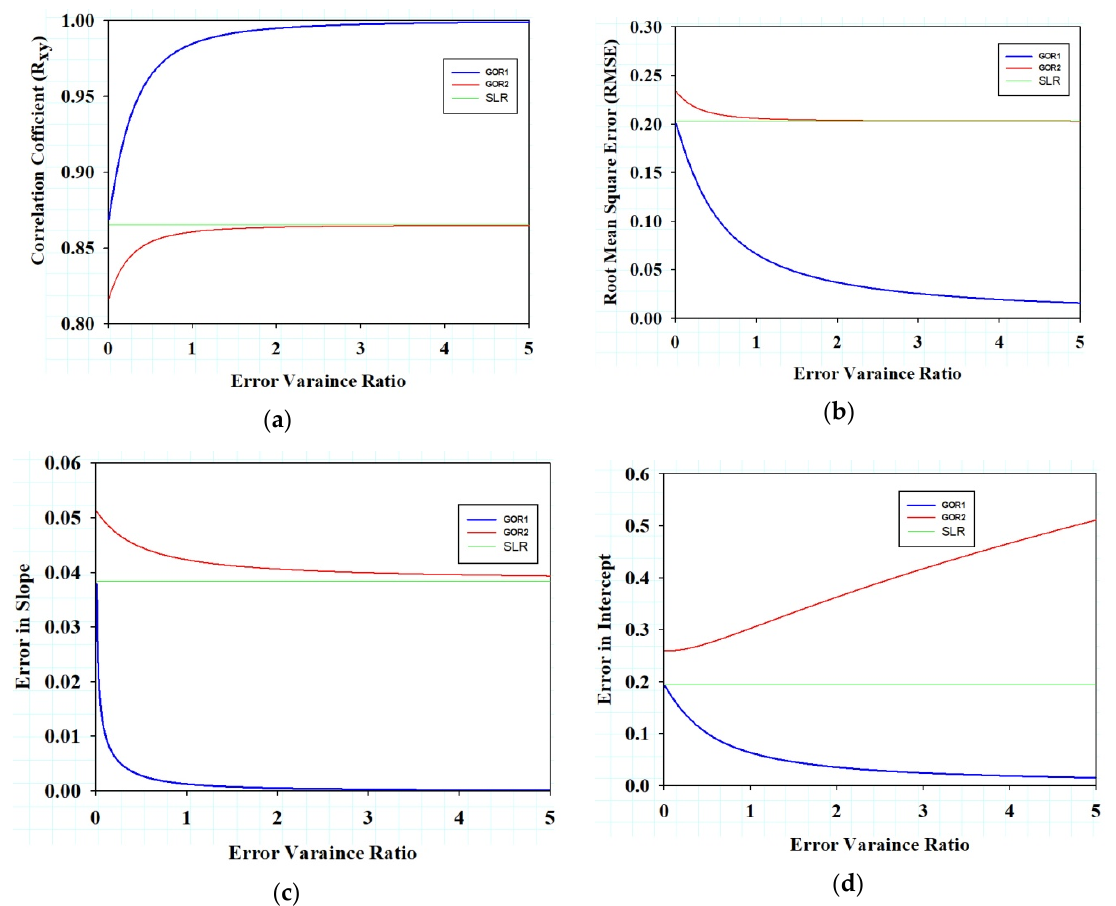
Figure 4. Comparison of the uncertainty in regression parameters for (M S,ISC − M wg ) data pairs using GOR1, GOR2, and SLR approaches considering function of error variance ratio: ( a ) Correlation Coefficient determination (R xy ), ( b ) Root mean square error (RMSE), ( c ) uncertainty values of slope and ( d ) uncertainty of intercept.